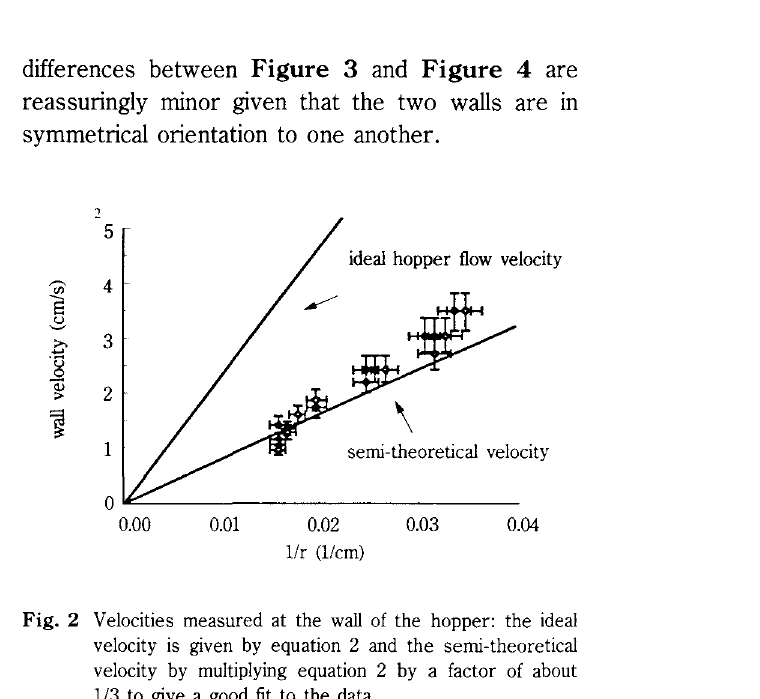
Fig. 2 Velocities measured at the wall of the hopper: the ideal velocity is given by equation 2 and the semi-theoretical velocity by multiplying equation 2 by a factor of about 1/3 to give a good fit to the data.